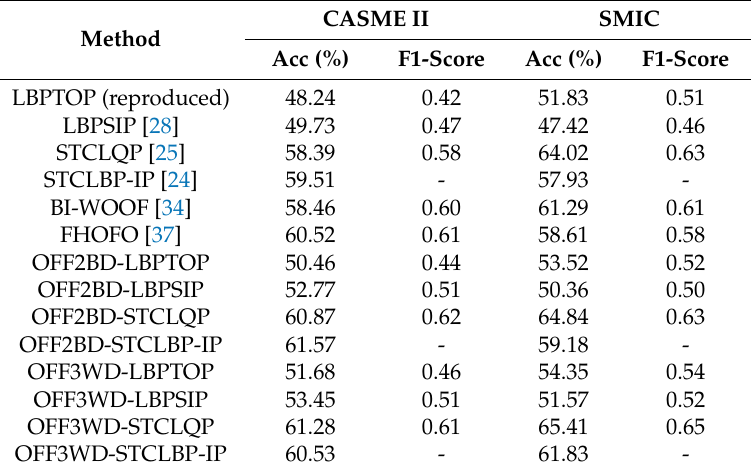
Table 4. Comparison with di ff erent ME recognition methods.